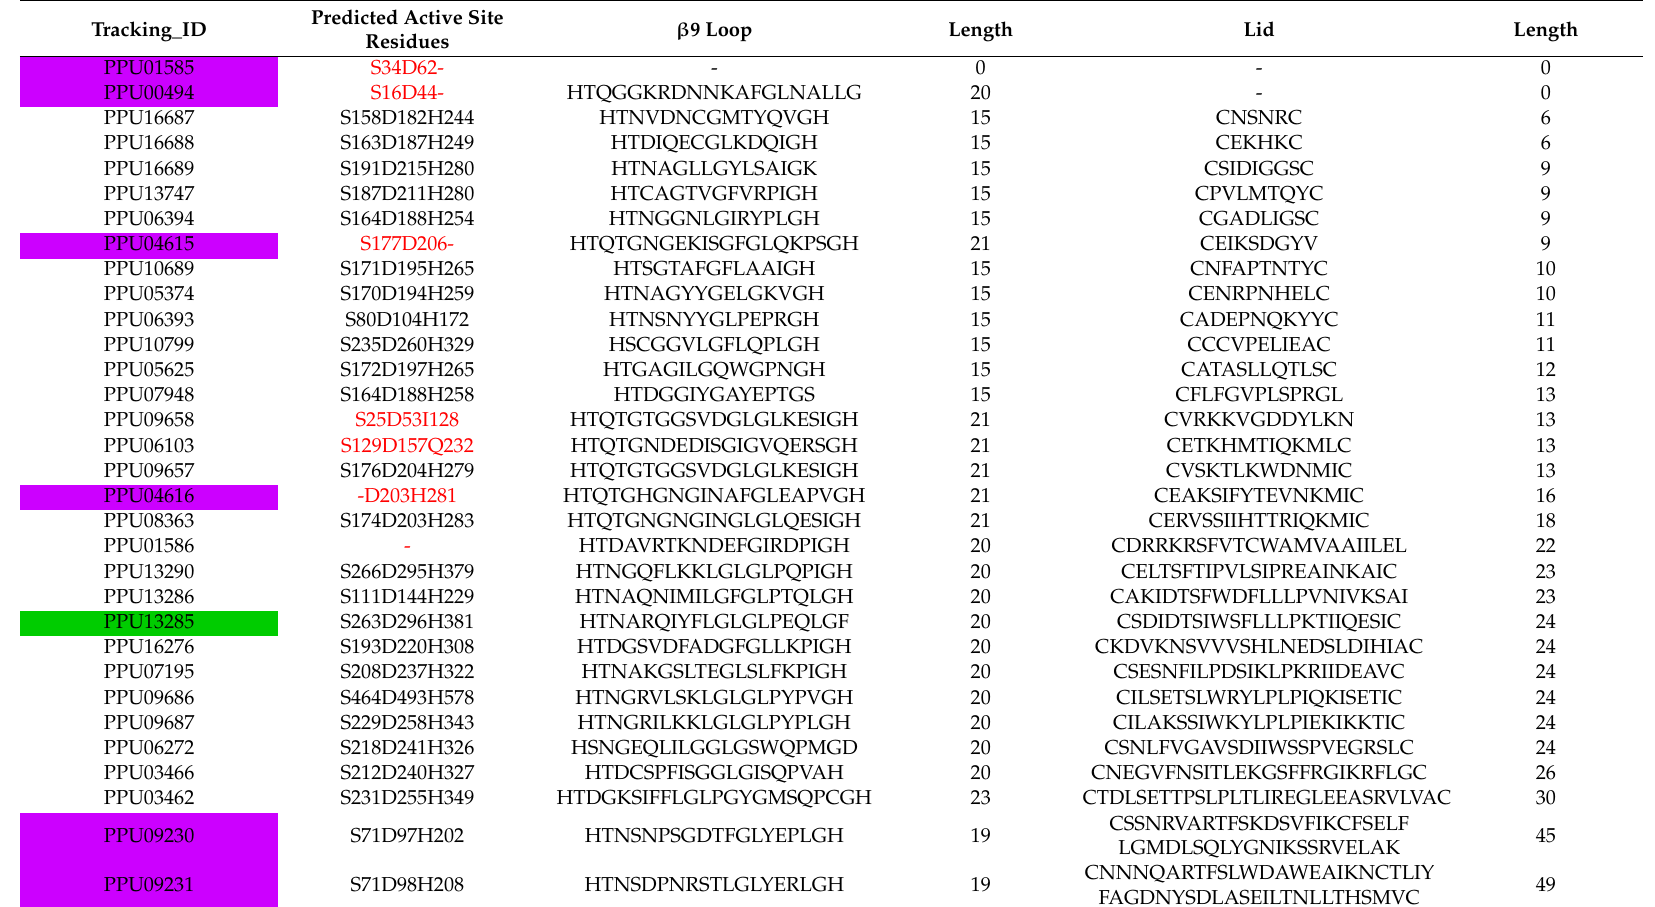
Background in purple: venom lipases; Background in green: salivary lipases; Letters in red: incomplete catalytic